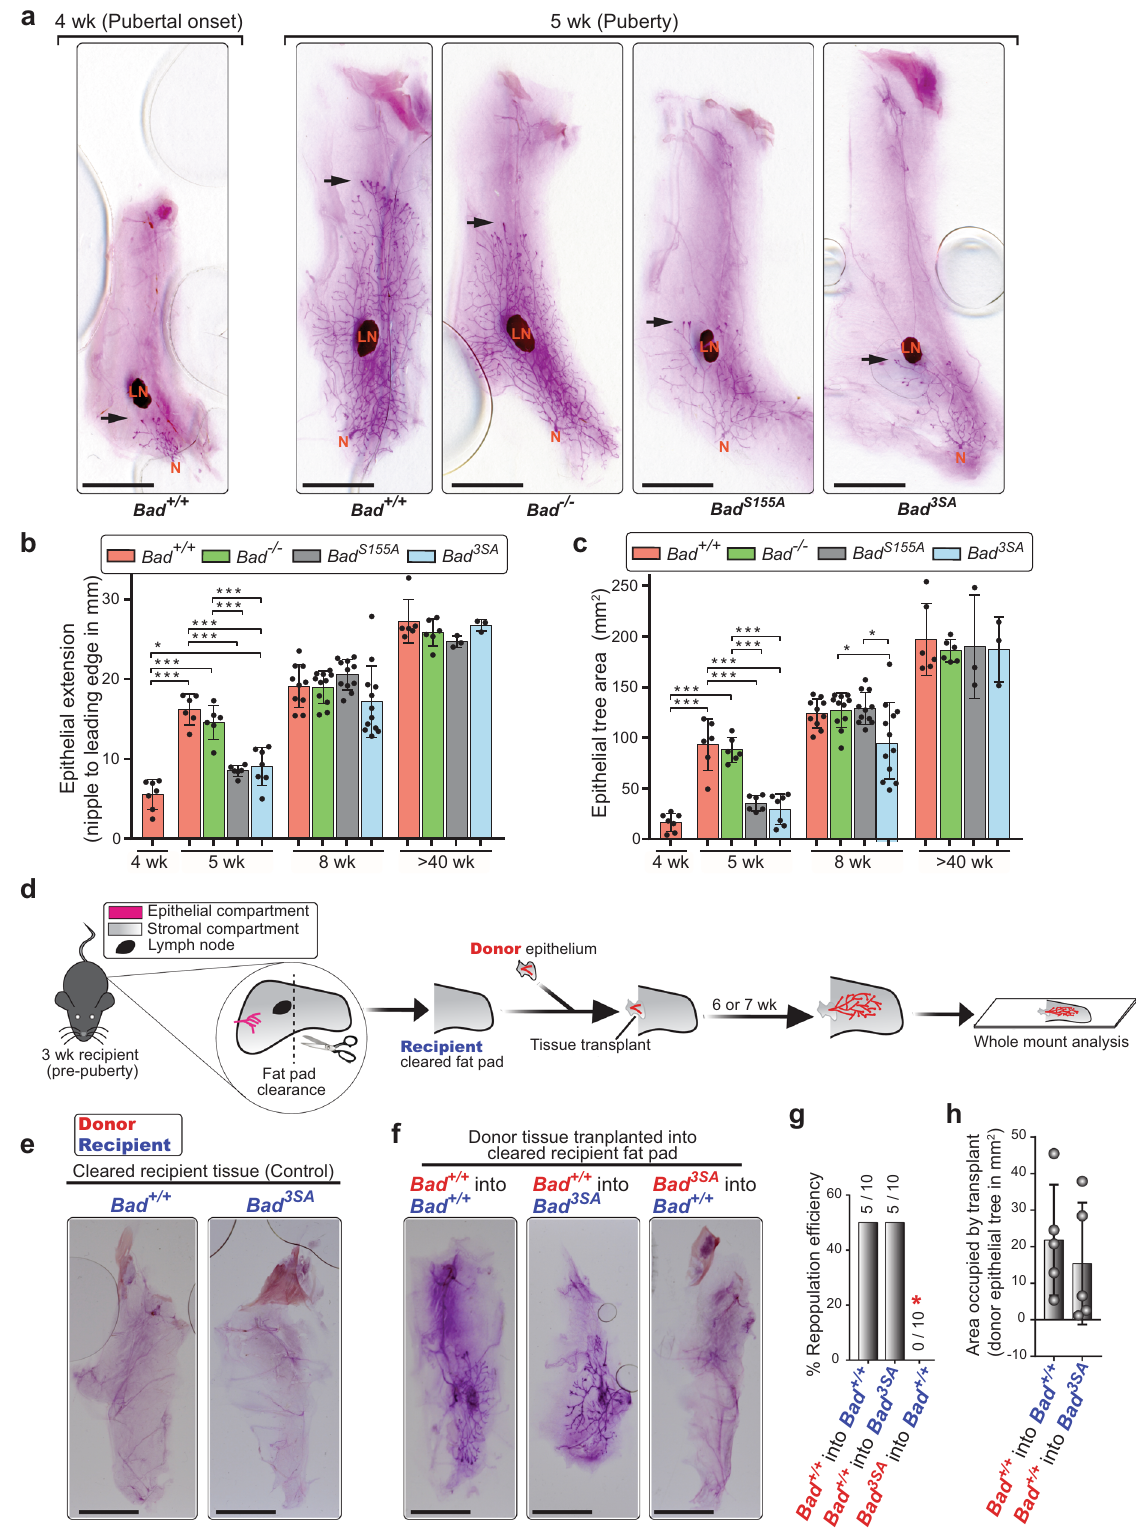
analyzed cell protrusion dynamics at day 3 of the 3D tubulogenesis assay (see Supplementary Movie 1). Figure 4 shows how cells at the edges of the multicellular cyst extend and contract protrusions into the ECM (Fig. 4a; green